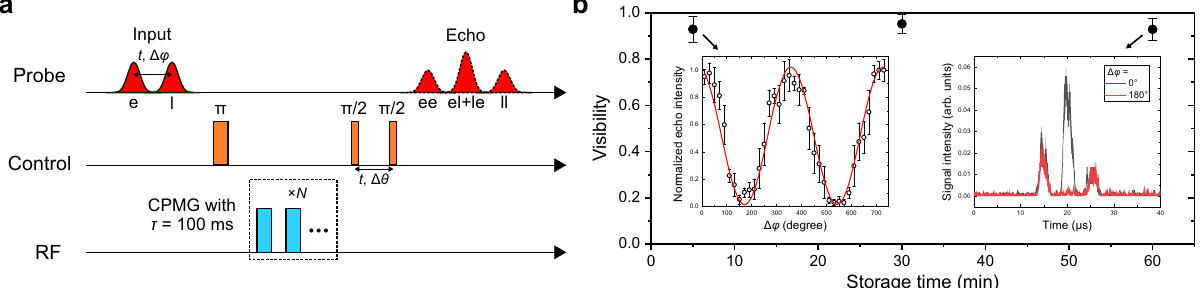
Fig. 4 Veri fi cation of the coherent nature of the memory. a Experimental sequence of the AFC echo interference, where e and l represent the earlier and the later, respectively. The interval of the two input pulses and that of the two read out pulses ( π /2) should be the same in order to overlap the echoes (el + le) of the two inputs. b Visibility versus the storage time. The left inset shows an interference pattern after 5 min storage, generated by recording the intensity of the echo in the middle while varying the relative phase Δ φ between the two input pulses. Each data point is averaged four times, and the error bars indicate one standard deviation of the echo area. After a storage time of 5, 30, and 60 min, the coherence is well maintained with a visibility of 93.0 ± 5.5%, 95.3 ± 4.2%, and 92.9 ± 4.9%, respectively. Single-shot oscilloscope traces of the signals after the 60 min storage are presented in the right inset. Constructive and destructive interference are observed at Δ φ = 0° and 180°,